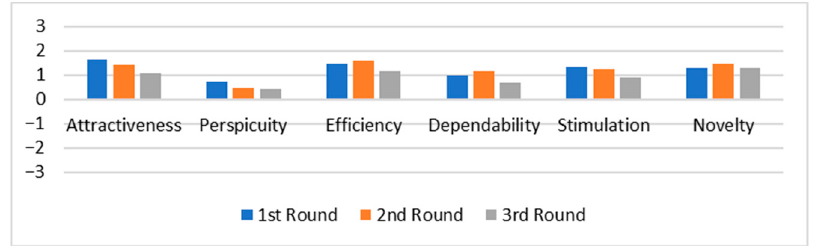
Figure 2. Mean of each UX dimension from UEQ.